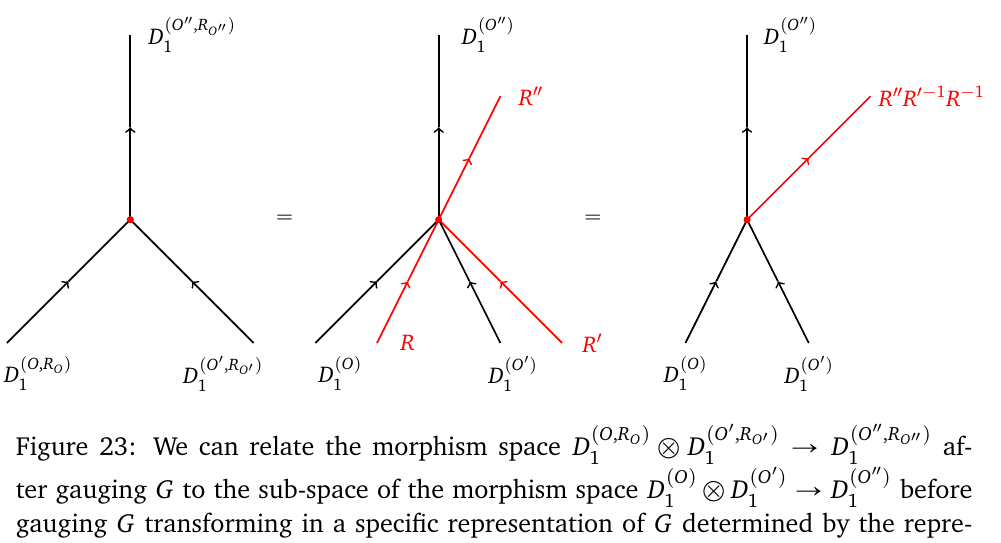
1 , R 2 , R O 1 q O 2 q b D p O Ñ D p O af- 1 1 1 1 q 2 q b D p O Ñ D p O before 1 1 1